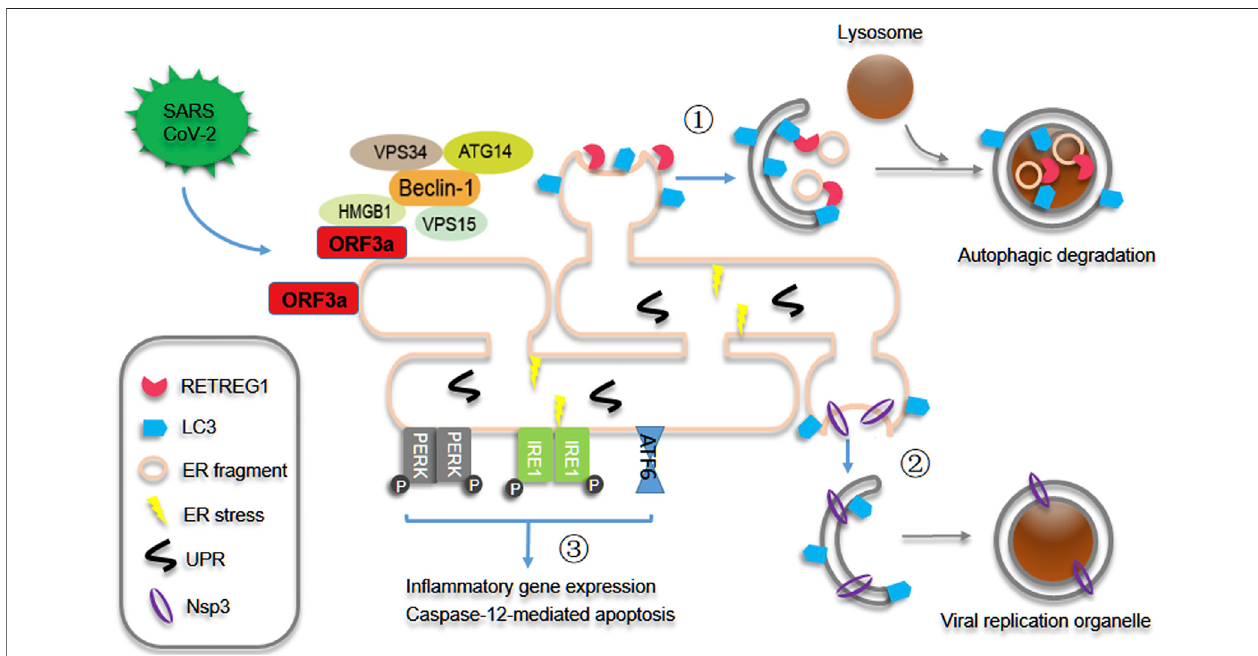
FIGURE 1 | SARS-CoV-2 ORF3a induces reticulophagy and reprograms ER homeostasis. During SARS-CoV-2 infection and replication, ORF3a interacts with HMGB1and recruitsitstranslocationfromnucleus toERandthen promotesHMGB1-Beclin1associationand RETREG1/FAM134B-mediated reticulophagy.Asresults ① ER integrated proteins and fragments are degraded and recycled through reticulophagy, and ② Nsp3-enriched ER regions are engulfed to form the double- membrane viral replication organelles probably through autophagy-likemechanism and then facilitates viral replication. Consequently ③ reticulophagy induces ER stress, and then triggers in fl ammatory gene expression and early caspase-12-mediated apoptotic